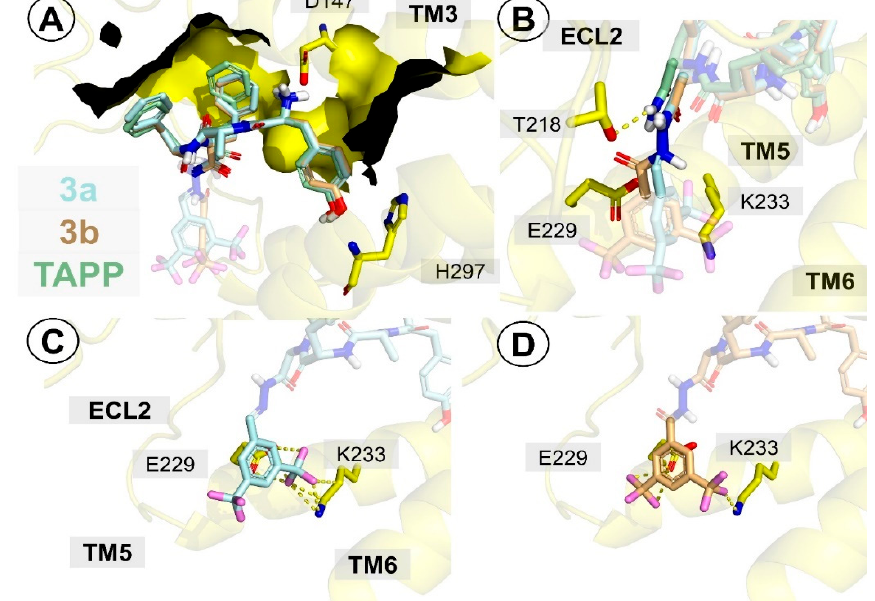
Figure 5. Binding modes of compounds 3a (palecyan) and 3b (light orange) in the MOR binding site (yellow). The ligands are shown as colored sticks. Several residues and transmembrane helices (relevant for each picture) are shown and labelled. Yellow dotted lines represent interactions. ( A ) Both compounds superimposed on TAPP (pink, from 6DDF [43]). ( B ) Focus on the interactions with T218 and compounds 3a , 3b , and TAPP together. ( C – D ) Focus on the interactions with E229 and K233, as well as compounds 3a ( C ), 3b ( D ), and 1c ( E ).